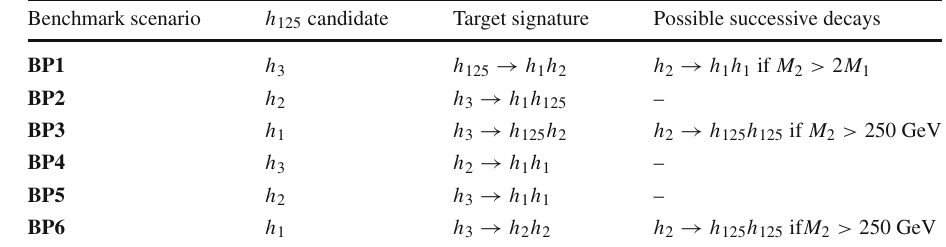
Benchmark scenario